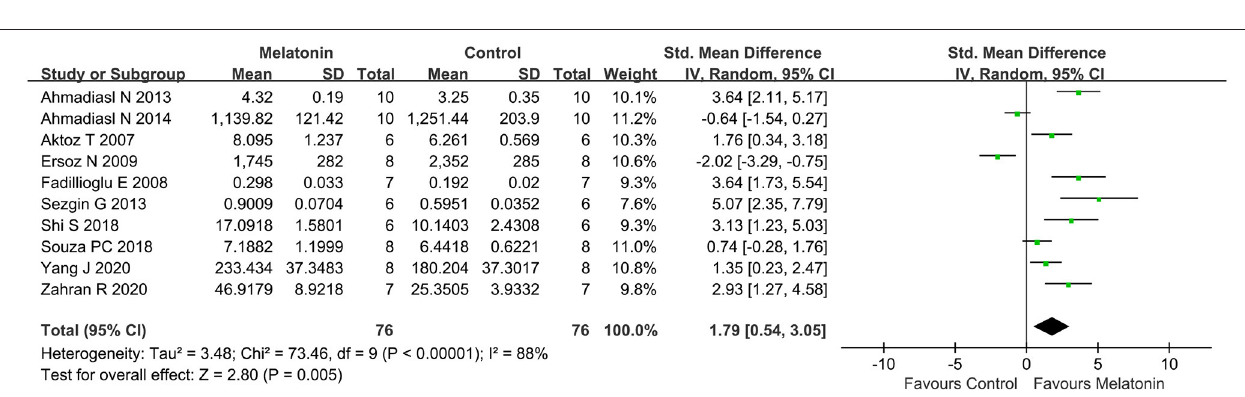
FIGURE 5 | Forest plot for the effects of melatonin on myeloperoxidase.